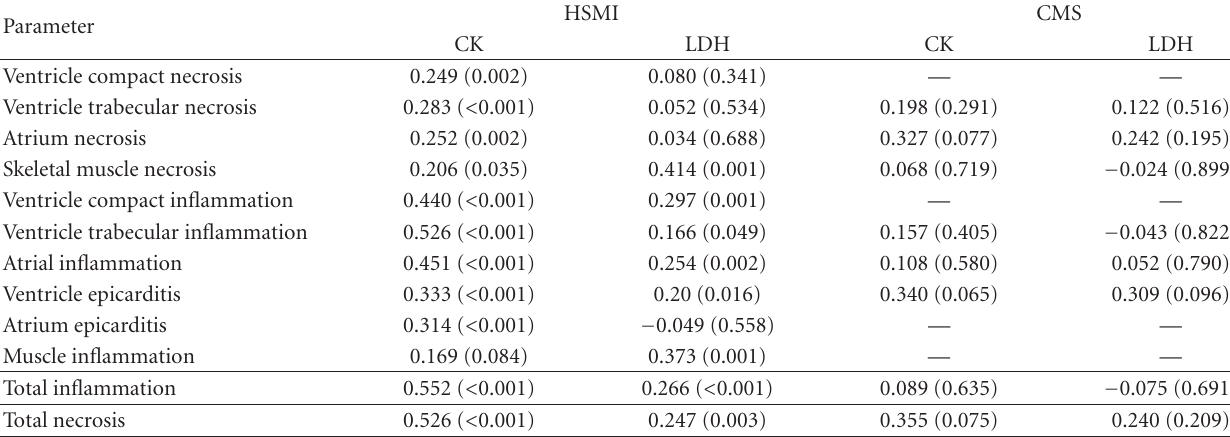
Table 3: The Spearman correlation coe ffi cient for anatomically distinct regions of the HSMI and CMS infected fish to creatine kinase (CK) and lactate dehydrogenase (LDH). P values given in parentheses.